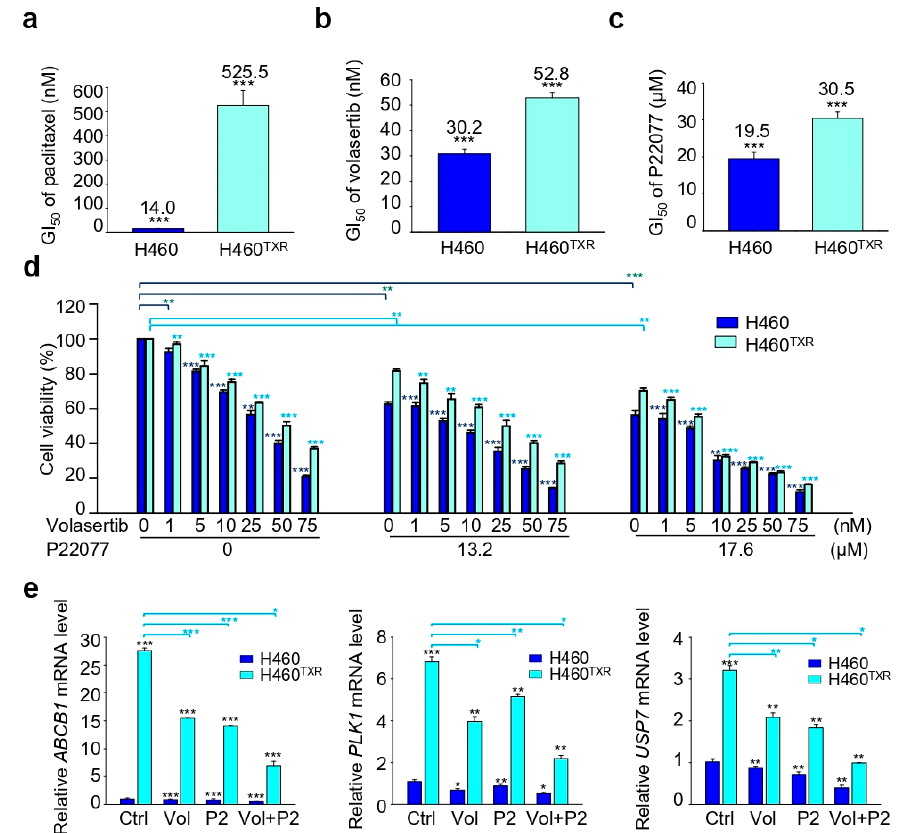
Figure 5. Combination of the USP7 inhibitor P22077 and PLK1 inhibitor volasertib shows synergic anticancer effects in paclitaxel-resistant lung cancer. ( a – c ) NCI-H460 and NCI-H460 TXR cells were treated with paclitaxel ( a ), volasertib ( b ), or P22077 ( c ) for 48 h in a concentration-dependent manner. The percentages of viable cells were measured by a cell viability assay. The bar graph presents the mean values of half maximal growth inhibitory concentration (GI 50 ). ( d ) Combination treatment with volasertib and P22077 was performed in NCI-H460 and NCI-H460 TXR cells. Cells were grown for 48 h in the presence of 0, 13.2, or 17.6 µM P22077 and volasertib at the indicated concentrations. The percentages of viable cells were measured by a cell viability assay. ( e ) QRT-PCR was performed for ABCB1 , PLK1 , and USP7 in NCI-H460 and NCI-H460 TXR cells treated with 14 nM volasertib (Vol) and 17.6 µ M P22077 (P2) for 48 h. Three independent experiments were performed and comparisons within groups were presented as the mean ± SDs. (* p ≤ 0.05; ** p ≤ 0.01; *** p ≤ 0.001). To understand their efficacy for arresting cancer cell growth, the cells were co-treated with the PLK1 inhibitor volasertib and USP7 inhibitor P22077 (Figure 5d, Table 1). The concentration of P22077 was fixed at 13.2 µM or 17.6 µM, which corresponds to the GI 20 and GI 30 values in NCI-H460 TXR cells, respectively, while volasertib was dosed in a concentration-dependent manner in both NCI-H460 and NCI-H460 TXR cells (Figure 5d). The combination index (CI) value was measured following combination treatment with volasertib and P22077. When cells were treated with P22077 at a concentration of 13.2 µ M or 17.6 µ M, the GI 50 of volasertib was reduced to 6.4 nM and 2.4 nM, respectively, in NCI-H460 parental cells; by contrast, the GI 50 of volasertib alone was 30.2 nM.